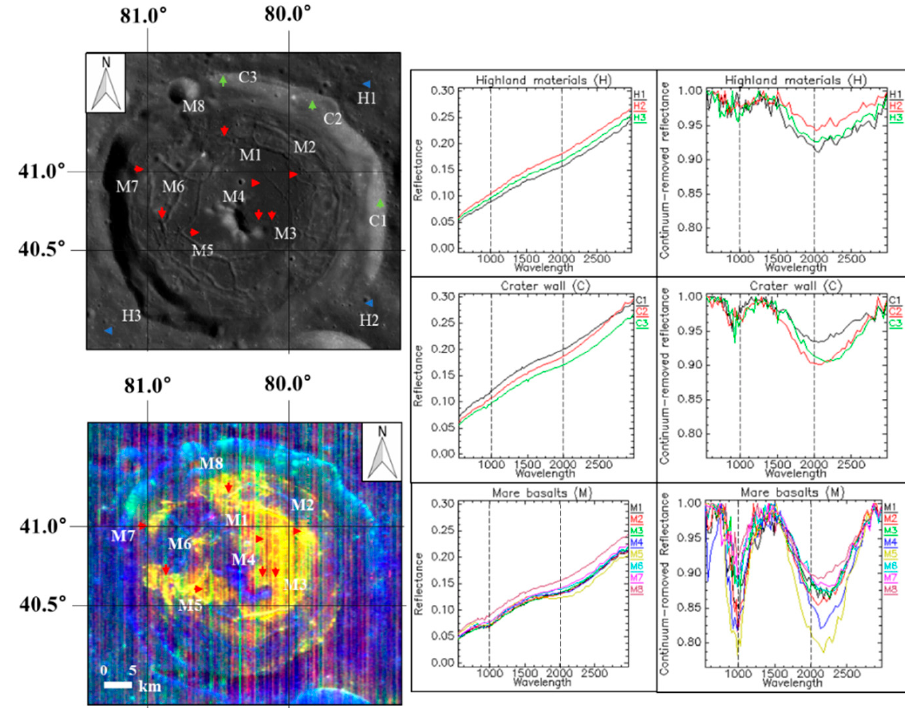
Figure 6. The WAC base map of the crater Lavoisier E (Figure 4b) shows the locations in the highlands (H1–H3), crater wall (C1–C3), and mare basalts (M1–M8). The WAC base map was taken from https://quickmap.lroc.asu.edu, accessed on 1 April 2022. To the right, the corresponding reflectance spectra and continuum-removed spectra are shown. The dashed lines in the spectra indicate the wavelengths of 1000 nm and 2000 nm. On the lower left, the RGB composite derived from the M 3 level 2 data is